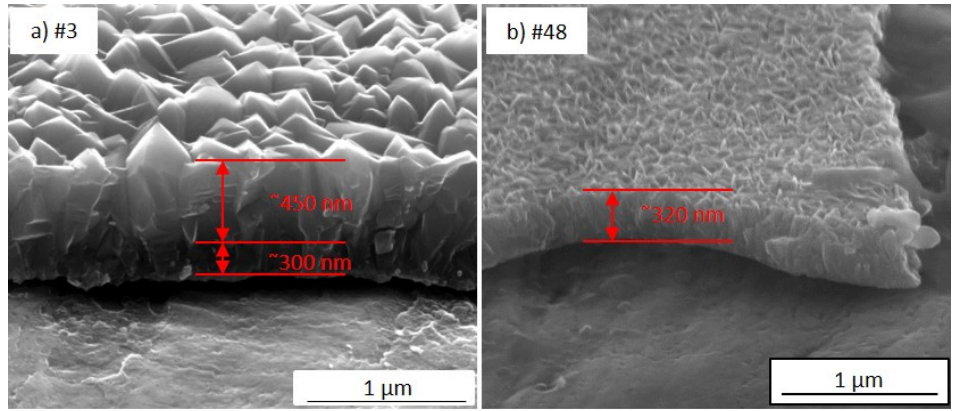
Figure 5. SEM images of the cross-section of the portion #3 ( a ) and #48 ( b ) (100,000× magnifica- tion).